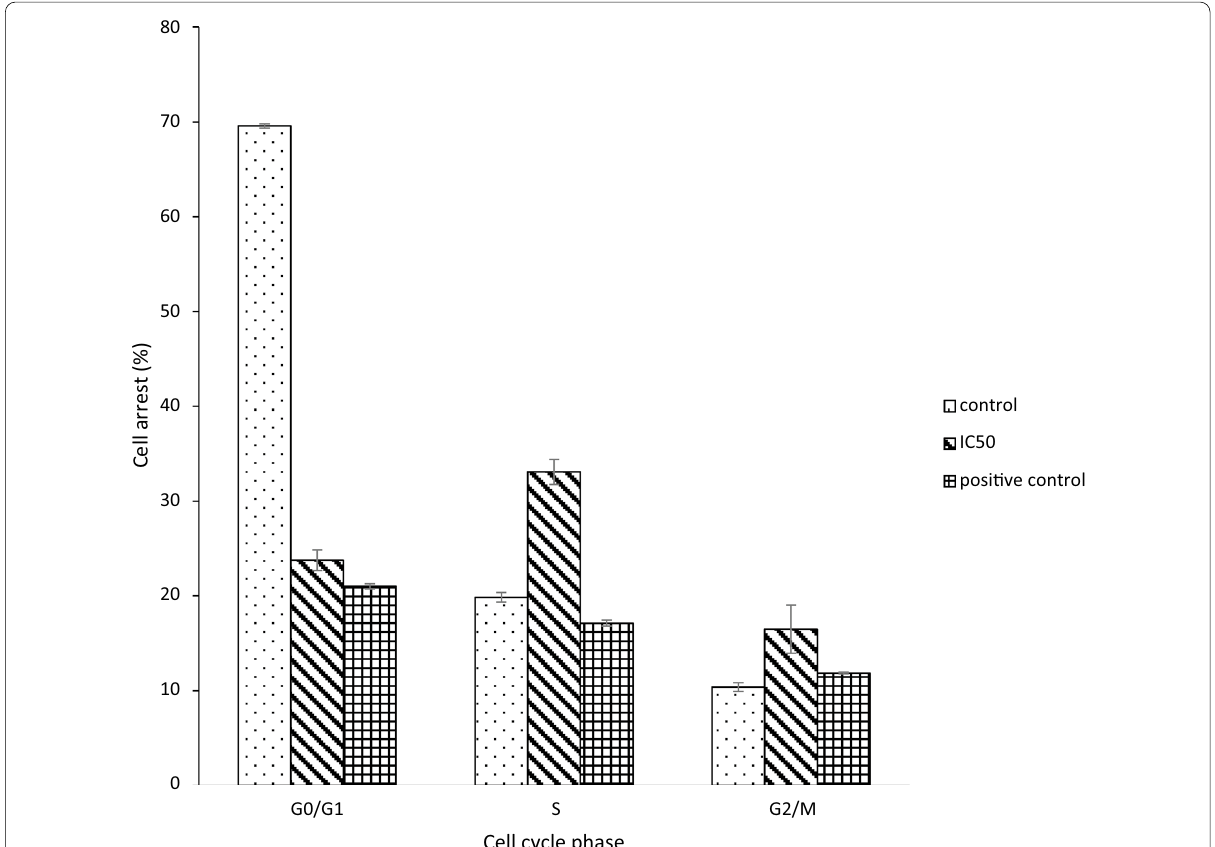
Fig. 8 Effects of the IC 50 CNDCM leaf extracts on the flow cytometric cell cycle analysis of the MCF-7 cells. The cells were treated for 72 h. The statistical significance at p < 0.05 compared to